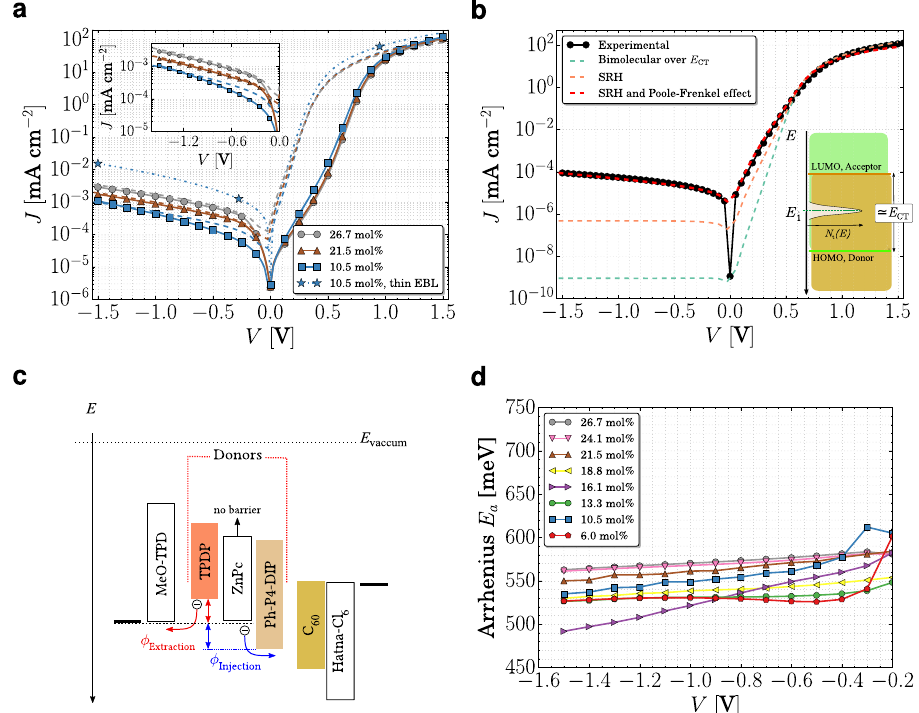
Fig. 4 Simulated JV characteristics of different D – A systems. Simulated (dashed lines) compared to experimental (symbols and solid lines) for devices based on: a TPDP:C 60 at three representative concentrations and b ZnPc:C 60 (50 wt%). Also shown in ( b ) are the JV characteristics for SRH process in the absence of Poole-Frenkel effect and bimolecular generation over E CT . Inset in ( a ) shows the reverse region in detail and in ( b ) a schematic representation of a mid-gap trap distribution in the donor – acceptor system. Mobilities and recombination rates were optimized to achieve a good agreement with the experimental data (see Supplementary Table 6). c Schematic representation of the energy level of the three systems showing an extraction and an injection barrier. A barrier-free system is also shown. d Activation energy for TPDP:C 60 extracted from temperature-dependent JV measurements. The current was measured at temperatures varying from 223.15 to 303.15 K with Δ T = 10 K. For each bias, the logarithm of the current was plotted versus 1/T , and E a was extracted from the slope of the curve. The fi t for V = − 1.5 V is shown in Supplementary Fig.